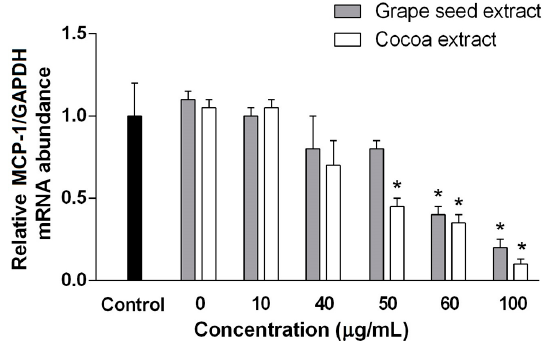
Figure 4. Effect of grape seed and cocoa extracts on production of relative MCP-1 mRNA levels in HUVEC. mRNA levels of MCP-1 were normalized using mRNA levels of glyceraldehyde 3-phosphate dehydrogenase (GAPDH). * statistically significant ( p -value < 0.05).